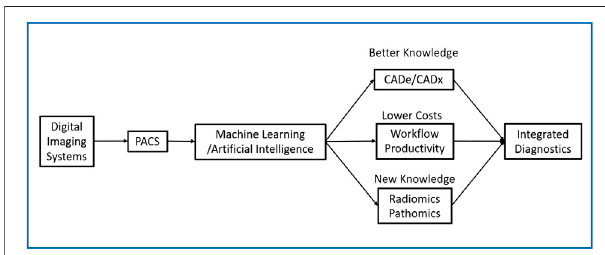
FIGURE 1 | Digital Transformation of Radiology with 3 Categories of Application of